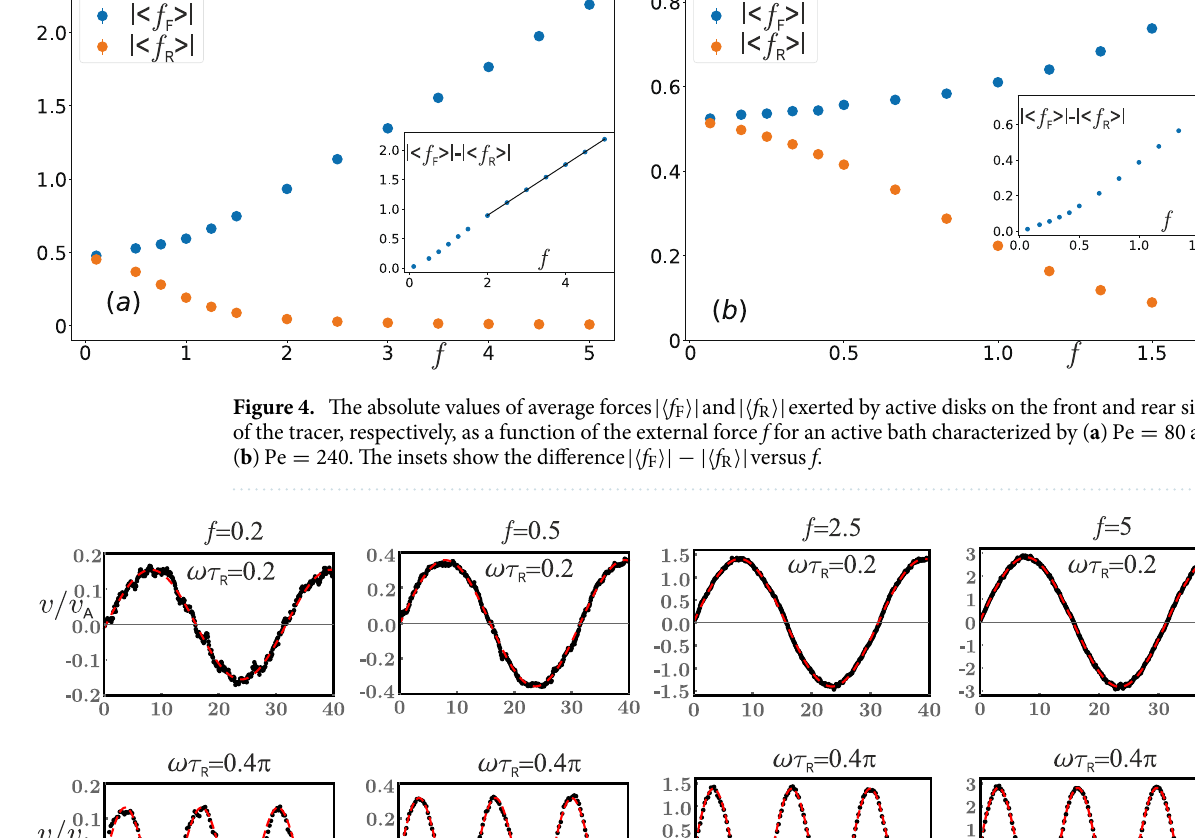
Figure 5. The x -component of tracer velocity v measured in units of active disk speed v A as a function of time t expressed in units of active disk reorientation time τ R . The tracer is driven with an external force f e ( t ) f sin (ω t ) through an active bath characterized by Pe = 0.2, 0.5, 2.5, 5 while the rows correspond to driving frequencies ωτ R = 0.2, 0.4 π , π , respectively. Here, f = black points present simulation data averaged over 100 independent simulation runs for each t , while red dashed lines provide the best fits of the data to the form